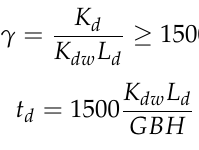
Figure 5. Sensitivity analysis on the mesh sizes along the flange width direction.